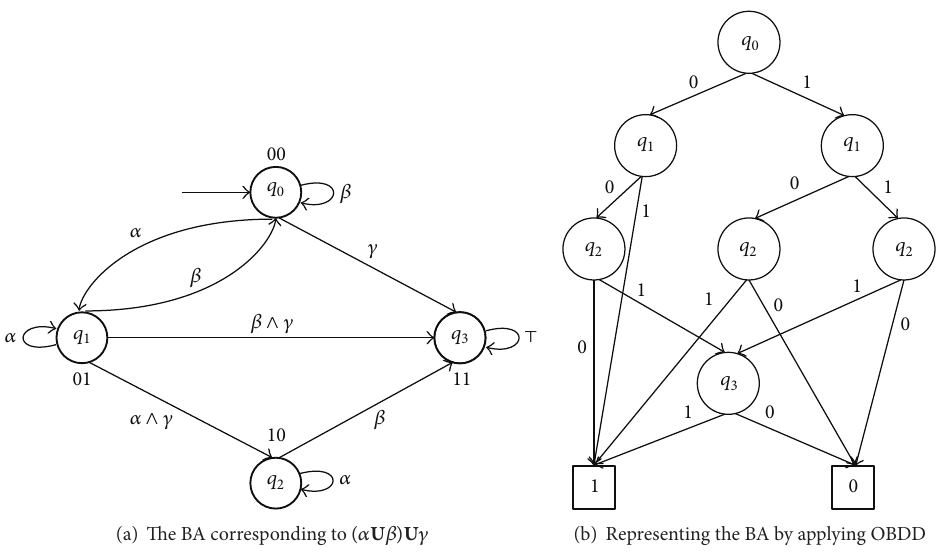
Figure 4: Rewriting B¨uchi automata into an